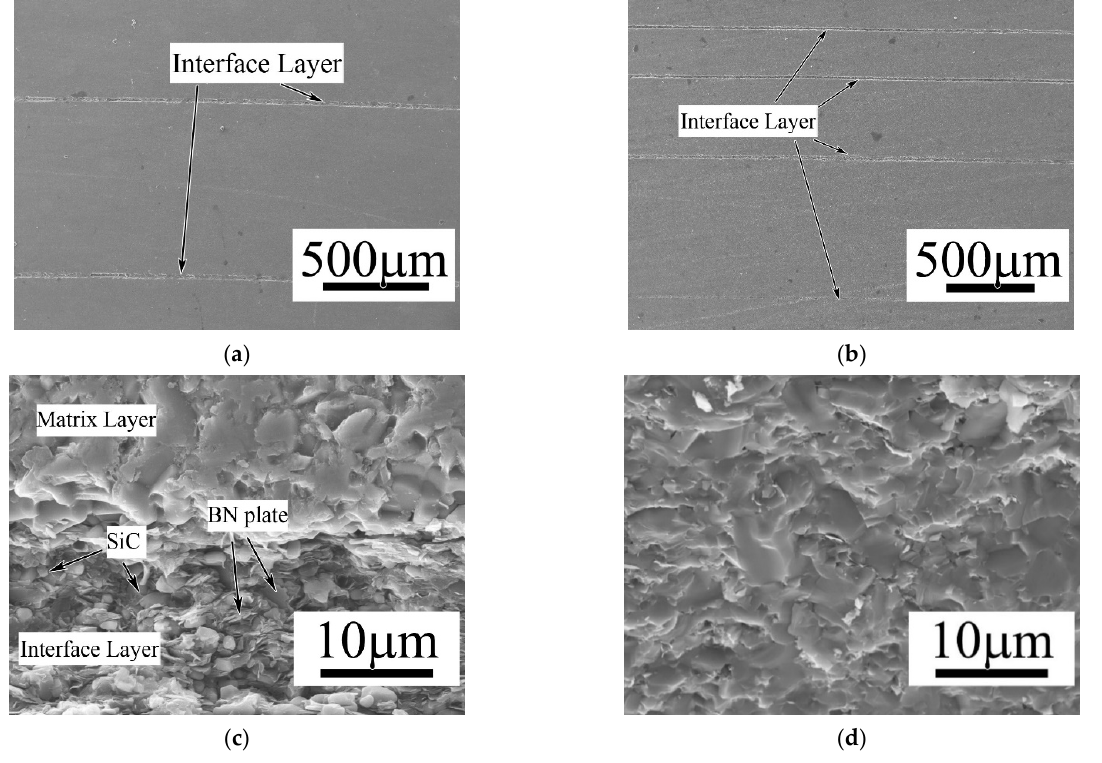
Figure 6. The microstructure of the laminated ceramics: ( a ) uniform-layered; ( b ) gradual-layered; ( c ) high magnification of the interface layer; ( d ) the fracturing surface of the pure-matrix laminated ceramic. The laminated SiC without the interface layer (pure-matrix) showed a high strength as well as toughness compared to the solid-state sintered SiC, SSIC. Previous studies [4,16] have shown that tape-casting is a colloid process that could leave fewer defects in the green body compared to the conventional dry-press method because the colloid process allows particles to be well-dispersed to avoid agglomerates. Since ceramics are a brittle material that is sensitive to defects, this would improve the strength of the final products. For liquid-phase-sintered SiC, the inter-granular crack deflection was the main toughen- ing mechanism [17,18]. The phase formed in the grain boundary of the liquid phase sin- tering SiC (in this study, the phase was YAG) was weaker than SiC, so the cracks tended to propagate along the grain boundary rather than through the grain [15]. Moreover, the residual stress generated by the thermal mismatch of the phase in the grain boundary further weakened the grain boundary, facilitating the inter-granular crack deflection [15,16]. The crack deflection elongated the cracking path, leading to the high toughness of the liquid phase sintered SiC, compared to that of the solid-state sintered SiC. The degree of the inter-granular fracture reflected the effect of the inter-granular crack deflection. A higher inter-granular fracture indicated a weaker grain boundary, and the liquid phase sintered SiC with a higher degree of the inter-granular fracture tended to have higher toughness but lower strength and lower Vickers hardness, compared to the SiC with a lower degree of the inter-granular fracture [19,20]. In this study, the laminated SiC showed a low degree of inter-granular fracture, so the strength and Vickers hardness of the pure- matrix sample remained high among the liquid phase sintered SiC (approximately 450– 650 MPa in strength and 18–20 GPa in Vickers hardness). The price for the high strength and hardness of the pure-matrix SiC was the reduced toughness. The toughness of the pure-matrix SiC (with 8 wt.% Al 2 O 3 -Y 2 O 3 ) was 6.9 MPa ∙ m 1/2 , lower than that of the SiC